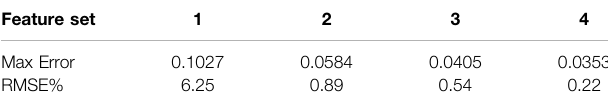
FIGURE 5 | Predictive performances of LIMM values for different input feature sets. (A) Feature set 1: net active and reactive power injections (B) feature set 2: voltage magnitudes and reactive power (C) Feature set 3: voltage magnitudes and phase angles (D) Feature set 4: voltage magnitudes and phase angles and net active and reactive power injections. TABLE 2 | DNN performance with different input feature